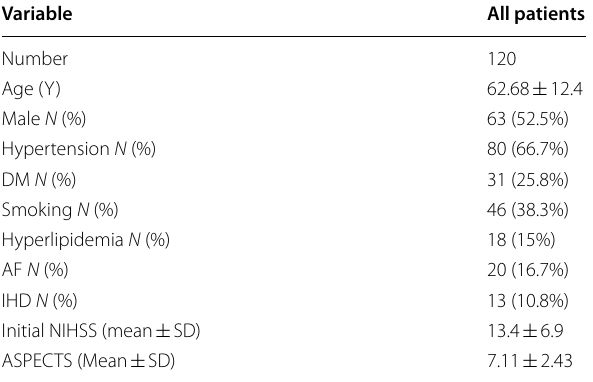
Table 1 Clinical characters, initial NIHSS, and ASPECTS of ischemic stroke patients